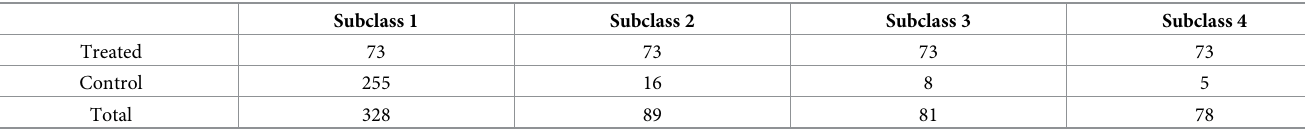
Table 7. Sample sizes by subclasses.